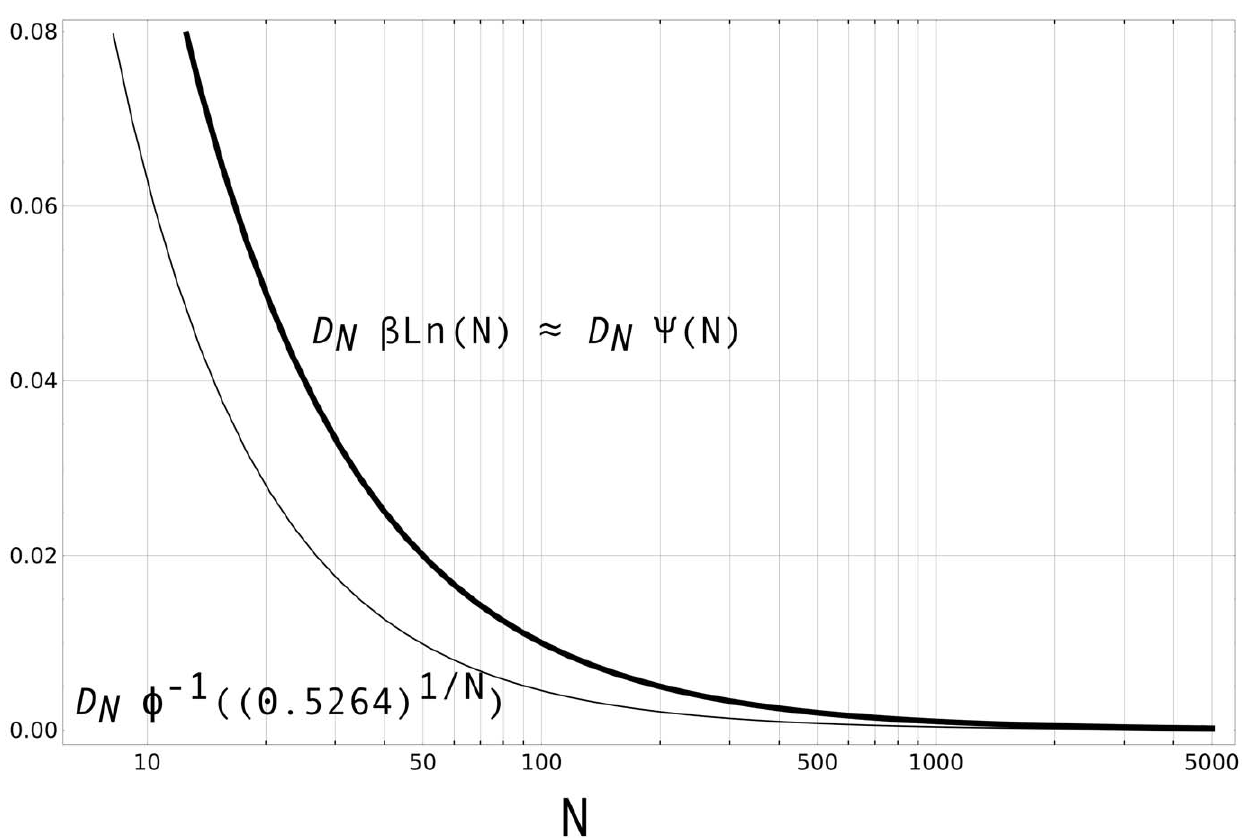
Figure 3. Comparison of the sensitivity of Gumbel/Logistic versus Normal populations to cultural loss due to population reduction. Comparison is done by plotting the derivative functions of, on one hand, b ln( N ) and Y ( N ) , and of W { 1 ((0 : 5264) 1 = N ) on the other. For the first b was set to 1; correspondingly, for the latter s was set to 1.28.